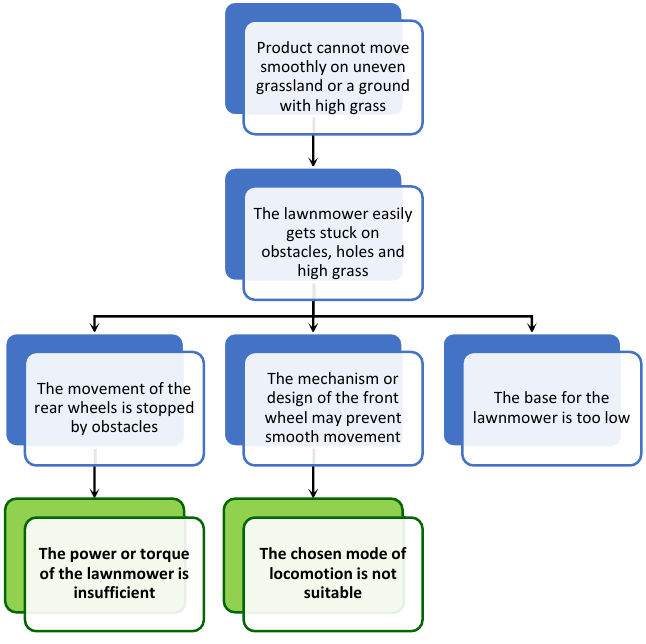
Figure 2. CEC analysis for constraint 1.